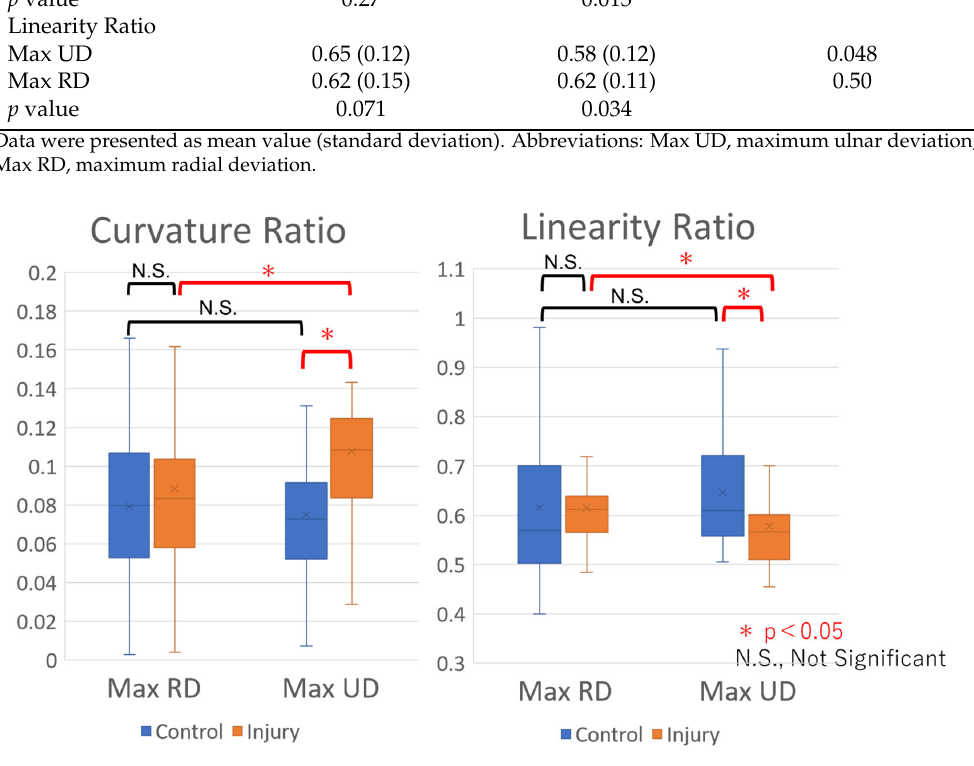
Figure 4. Curvature and linearity ratios in the study groups. The curvature ratio in maximum ulnar deviation (Max UD) was significantly higher and linearity ratio in Max UD was significantly lower in the injury group than those in Max UD in the control group and those in maximum radial deviation (Max RD) in the injury group.